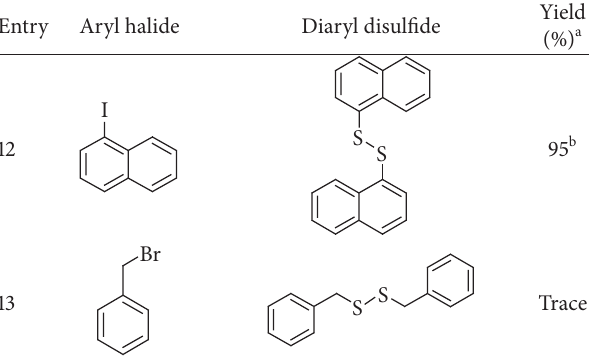
Table 2: CuI-catalyzed and KF/Al diaryl disulfides from aryl halides and CS 32− at 110 ∘